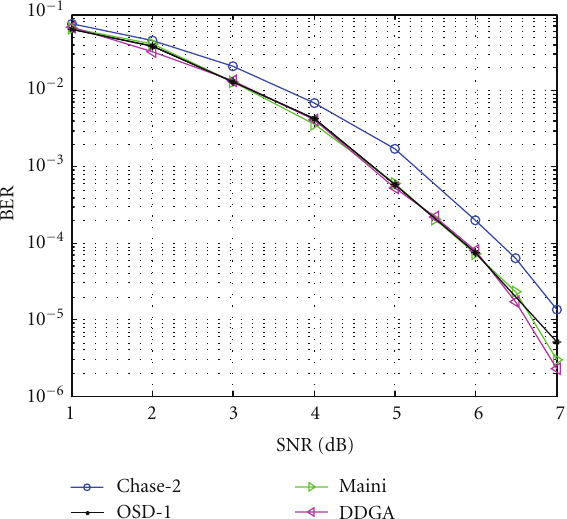
Figure 13: Performances of Chase-2, OSD-1, Maini, and DDGA algorithms for BCH (31,26,3)